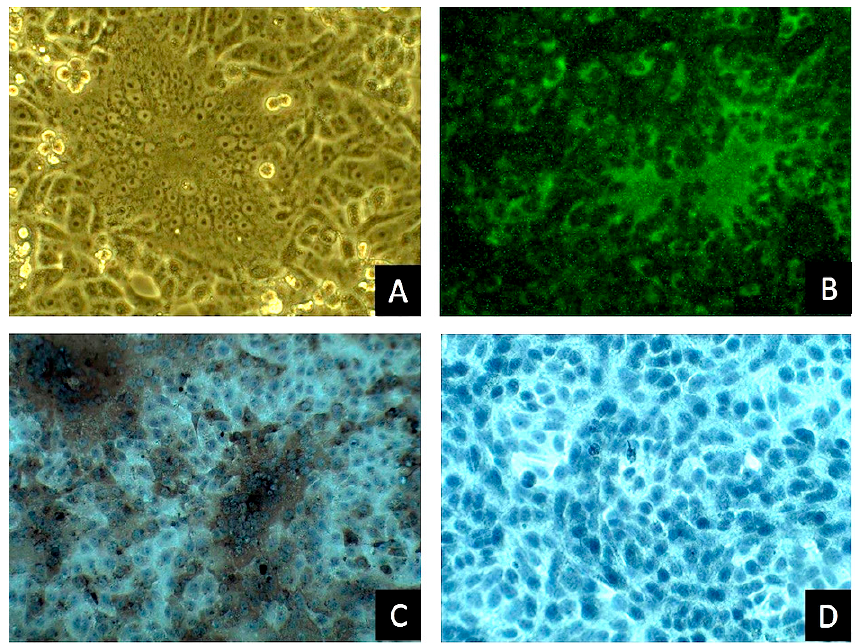
Figure 1. Detection of porcine epidemic diarrhea virus strain Pintung 52 (PEDVPT) infection in Vero cells. Typical PEDV-induced cytopathic effects (CPE) characterized by enlarged cells, cell fusion, and syncytia formation was present in cultures of PEDVPT passage 3-inoculated Vero cells ( A ). Positive signals located in the cytoplasm of typical syncytial cells were detected by immunofluorescence assay using PEDV hyperimmune pig serum ( B ) or by immunocytochemistry (ICC) using an anti-PEDV N protein monoclonal antibody ( C ). Non-PEDV infected Vero cells stained by ICC as negative control ( D ).